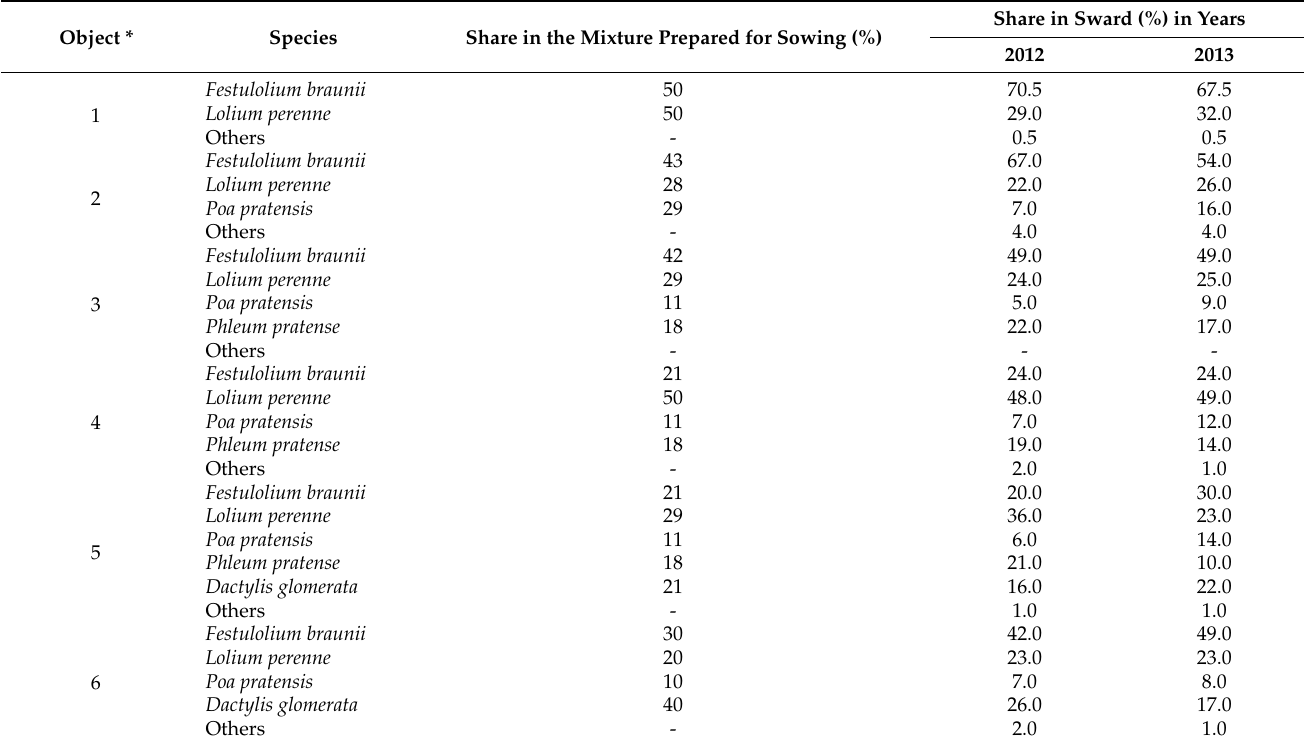
Table 5. Floristic composition of meadow sward (%) of experiment II from first cut in the years of research (2012–2013). Object * Species Share in the Mixture Prepared for Sowing